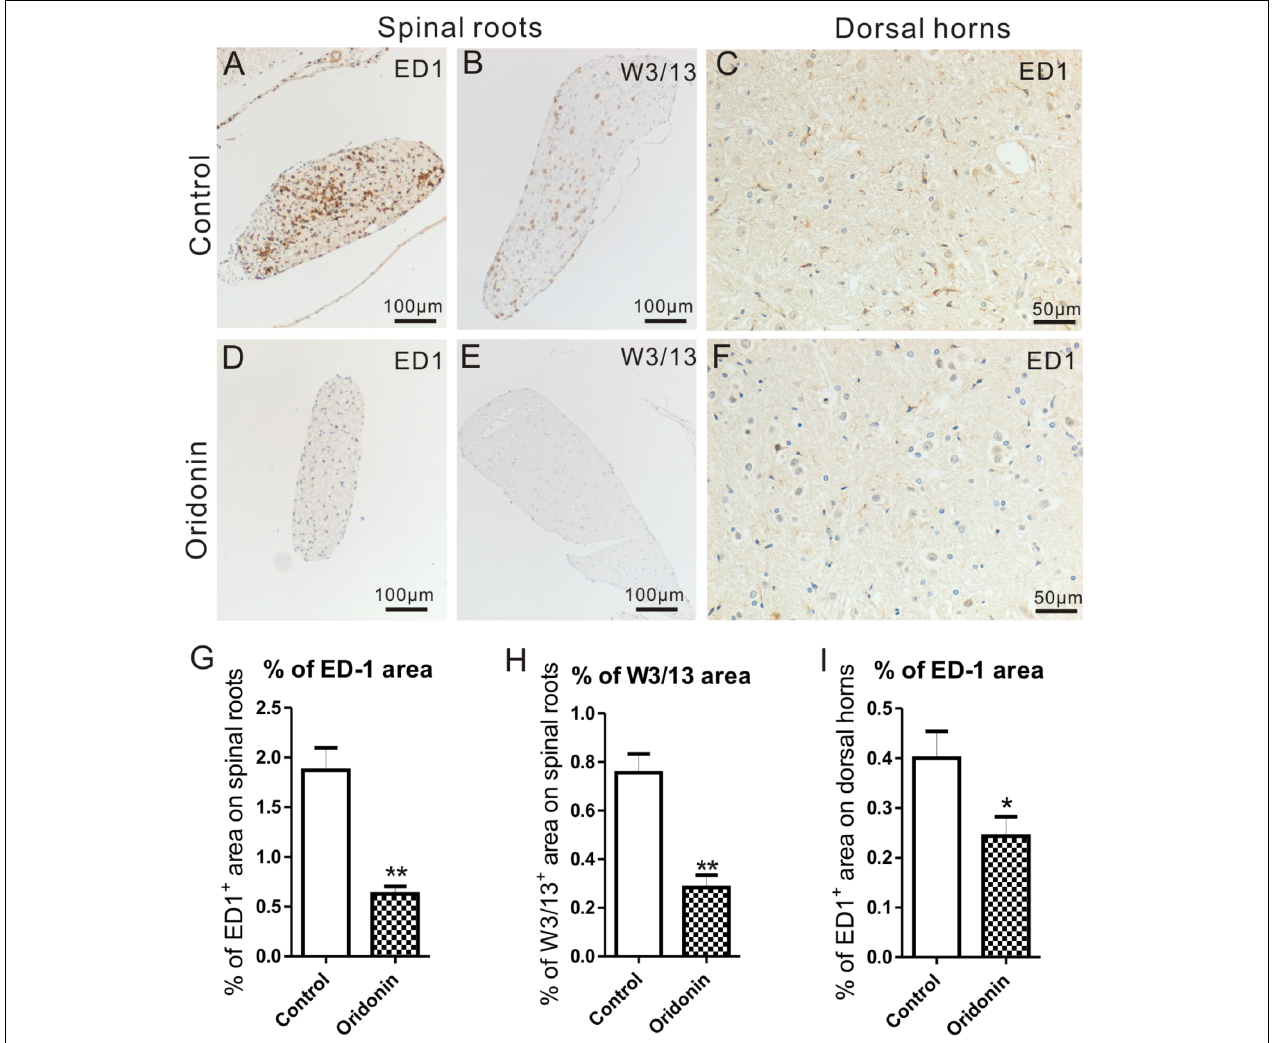
FIGURE 4 | Oridonin treatments attenuated cellular infiltration in spinal roots and inflammatory microglial activation in lumbar spinal cords of EAN rats. EAN Rats were preventively treated with Oridonin and sacrificed on Day 15, spinal cords were taken for immunohistochemical staining and analyzed, especially focusing on lumbar sections. Significant accumulation of ED1 + and W3/13 + cells was mainly observed in dorsal roots of our EAN rats (A,B) . Similar to sciatic nerves, they were mainly detected to concentrate around vessels in perineurium and endoneurium. Following the Oridonin treatment, their accumulations were significantly reduced (D,E,G,H) .The expression of ED1 in lumbar spinal cords was further analyzed. In lumbar spinal cords of EAN rats, significantly increased ED1 expression could be observed in the control group (C) . ED1 IR was mainly detected in gray matter, particularly in the superficial layers of dorsal horns. The density of ED1 IR in dorsal horns was then investigated, and it was significantly decreased by Oridonin treatment (F) , compared to the control group (I) . ∗ p < 0.05, ∗∗ p < 0.01 compared to the control group, n =